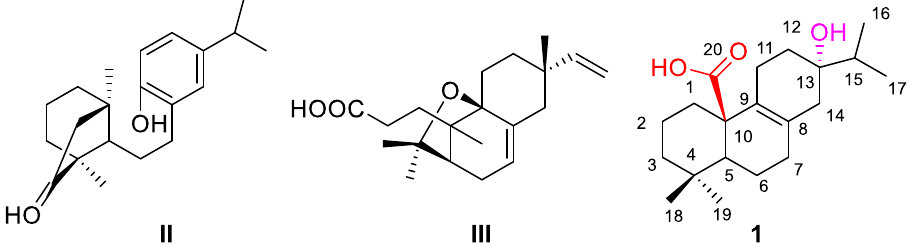
Figure 1. Chemical structures of rubesanolide D ( I ), kunminolide A ( II ), fladin A ( III ), and lophanic acid ( 1 ).